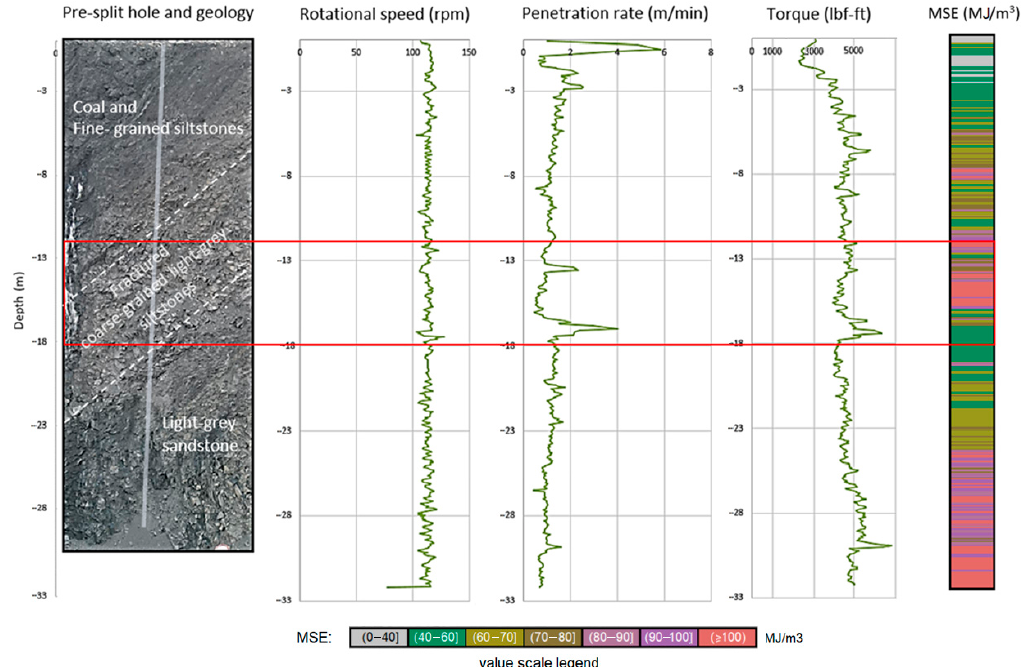
Figure 13. A dependence plot of MWD data on borehole depth for the borehole. No. 479 in block No. K 67–78.